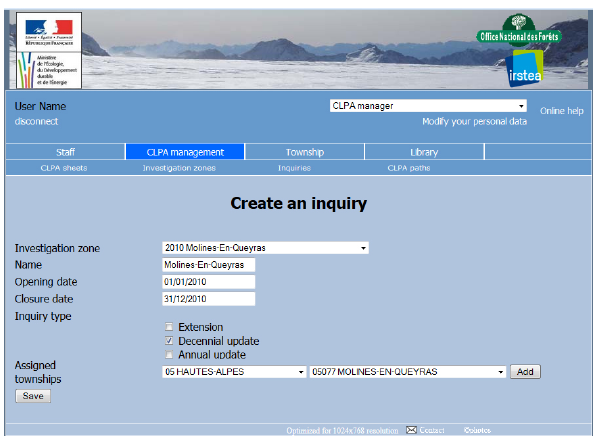
Figure 8. Graphical user interface of the management level to create a CLPA inquiry. An inquiry named “Molines-en-Queyras” is being created on an existing investigation zone. The inquiry time period, inquiry type and assigned township are defined.